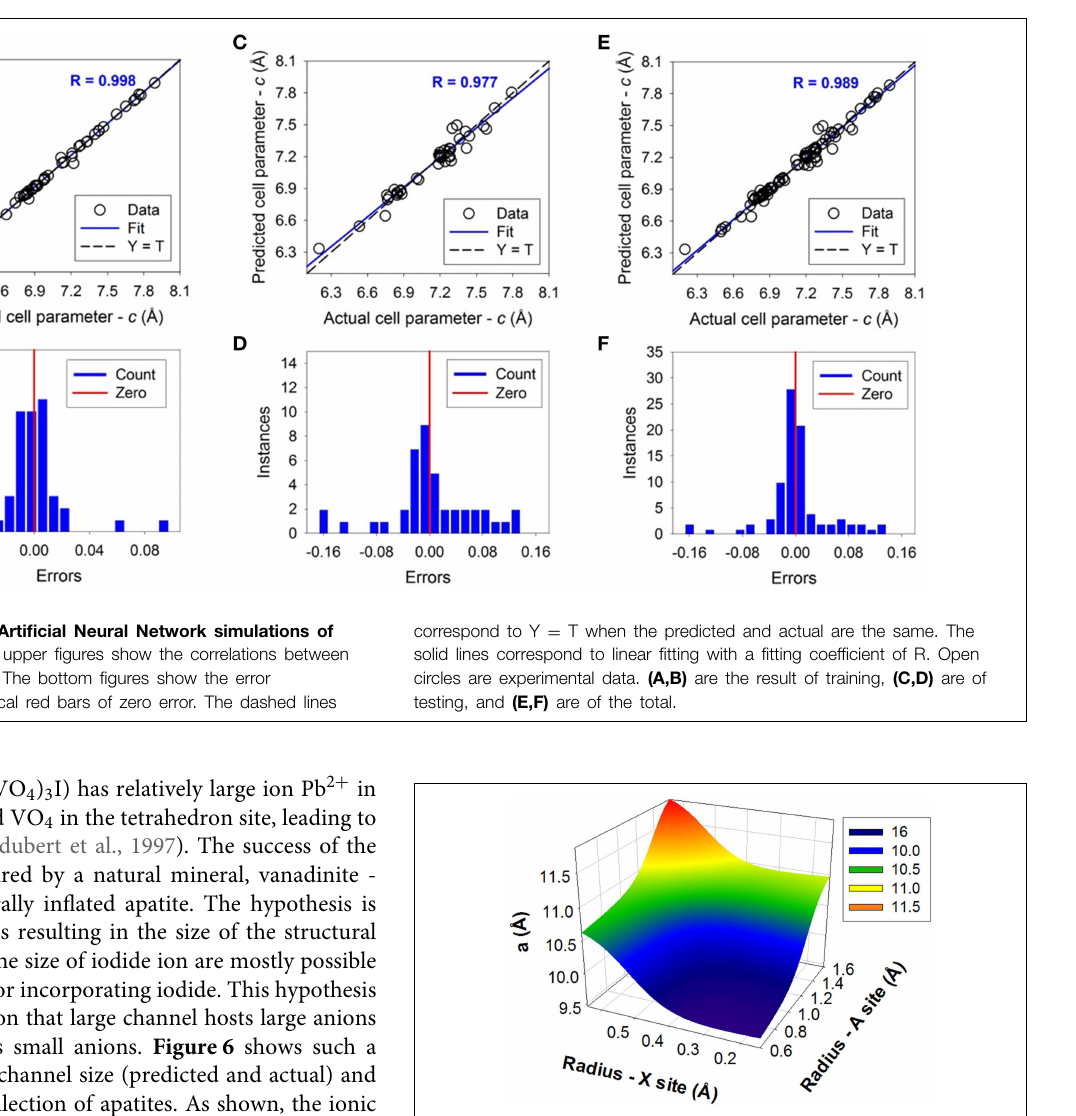
FIGURE 5 | An Artificial Neural Network for the prediction of unit cell parameter a . The figure is color coded with red color for high value and blue color for small value. For any given average radii of A and X site cations, the cell parameter a can be predicted by just reading the value at the surface of predicted cell parameter a